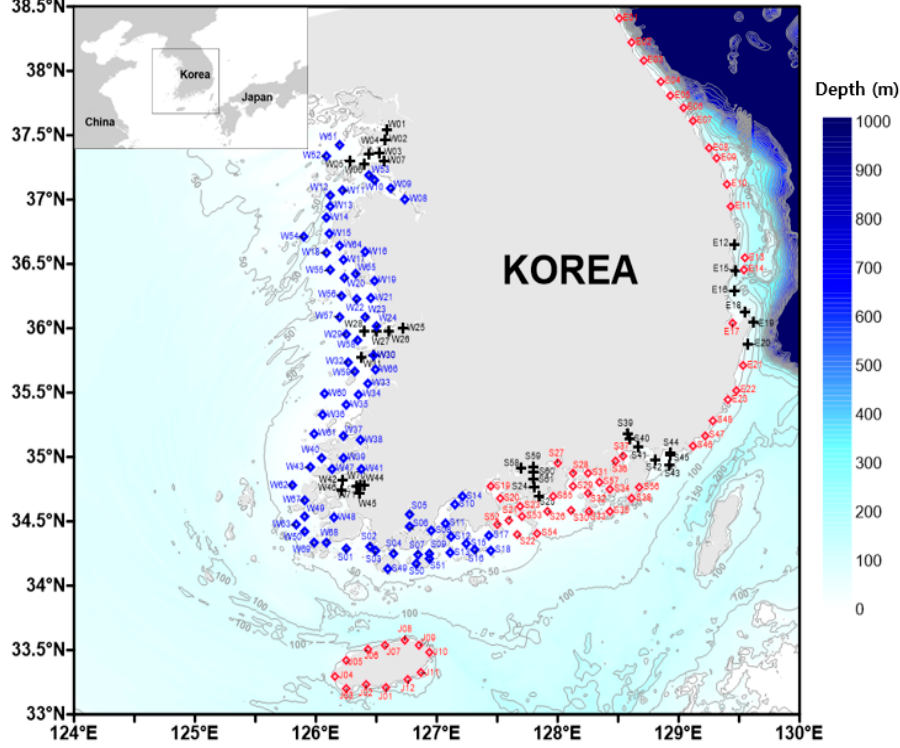
Figure 1. Map showing the sampling stations in the coastal zone of Korea. Blue and red diamonds represent stations analyzed during odd and even years, respectively, over five years (2015–2019). The cross marks indicate estuaries.